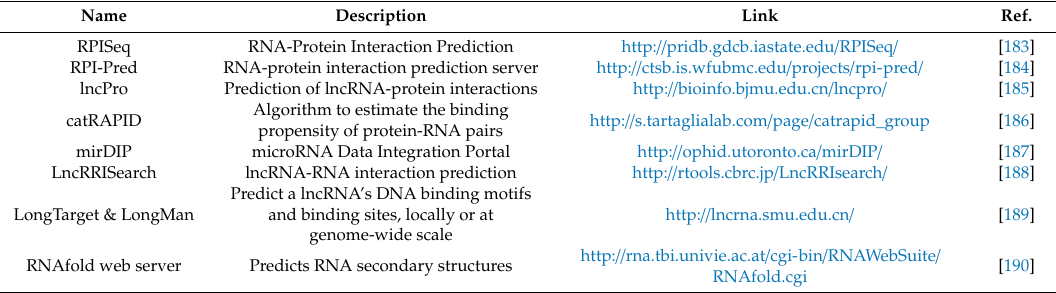
Table 7. Online tools useful for predicting lncRNA interactions and